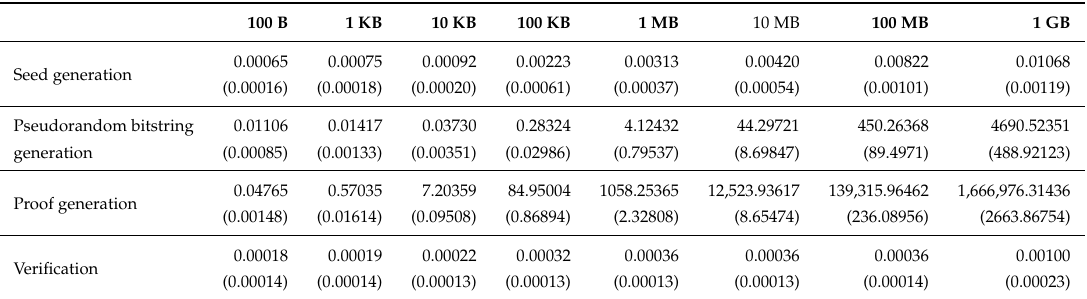
Table 3. Average computation time (ms) for authentication based on a hardcore function by data size (standard deviation in